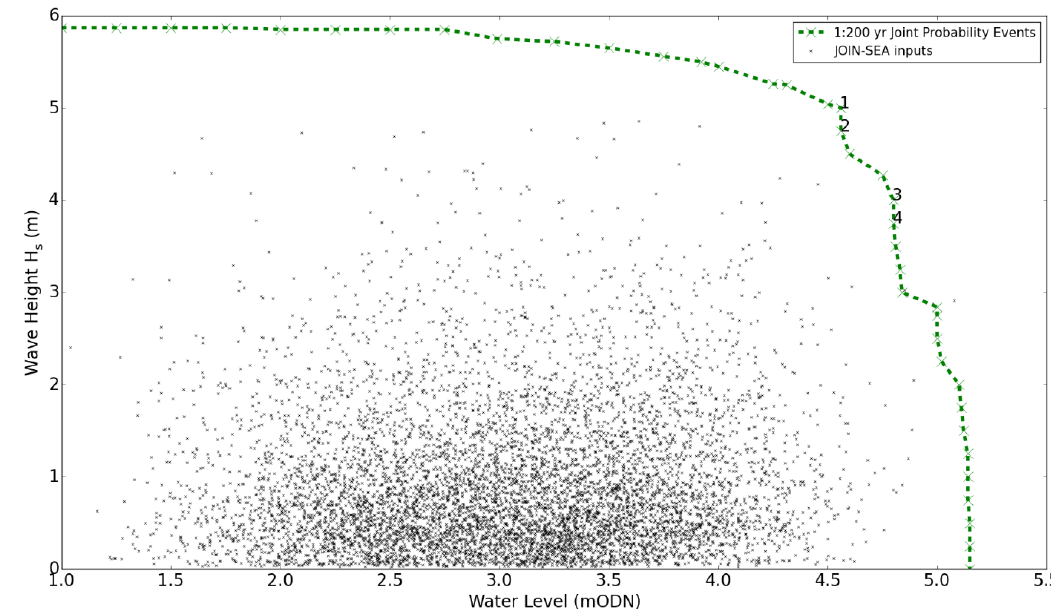
Figure 2. The 1:200 year joint probability distribution calculated from JOIN-SEA. Scenarios 1–4 are annotated, with specific parameters of these events shown in Table